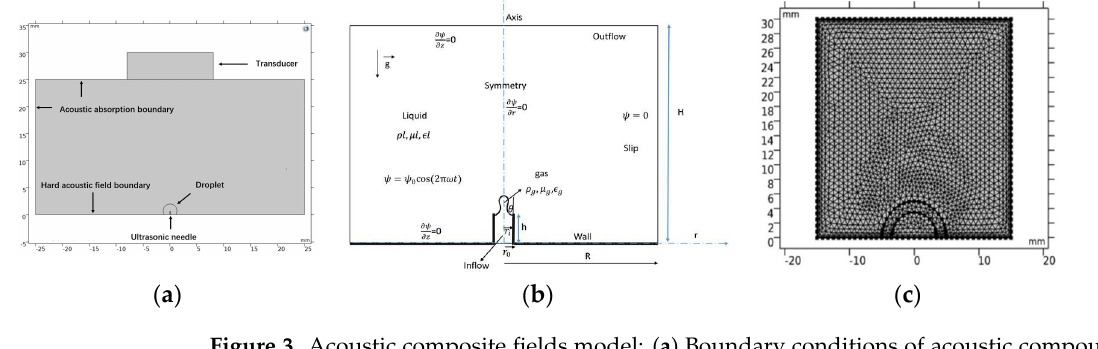
Figure 3. Acoustic composite fields model: ( a ) Boundary conditions of acoustic compound fields. ( b ) Computational domain for case of bubble formation from a needle, R = domain height, r 0 = needle outer radius, r i = needle inner radius, h = needle height, ρ = density, µ = viscosity, (cid:101) = relative permittivity, ψ = electric potential, ω = angular frequency of electric field oscillation, θ = contact angle with respect to needle inner surface, 𝑔⃗ is the gravity vector, subscripts l and g denote, respectively the liquid and gas phases ( c ) Grid division of composite fields model.